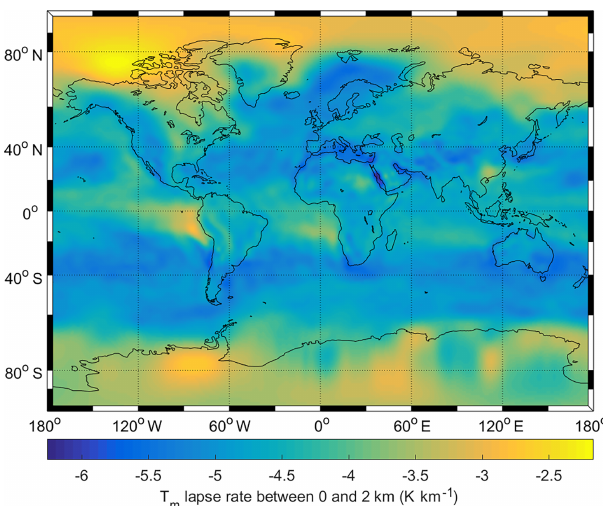
Figure 3. Global annual mean T m lapse rate in the height interval 0–2km from NCEP2 in